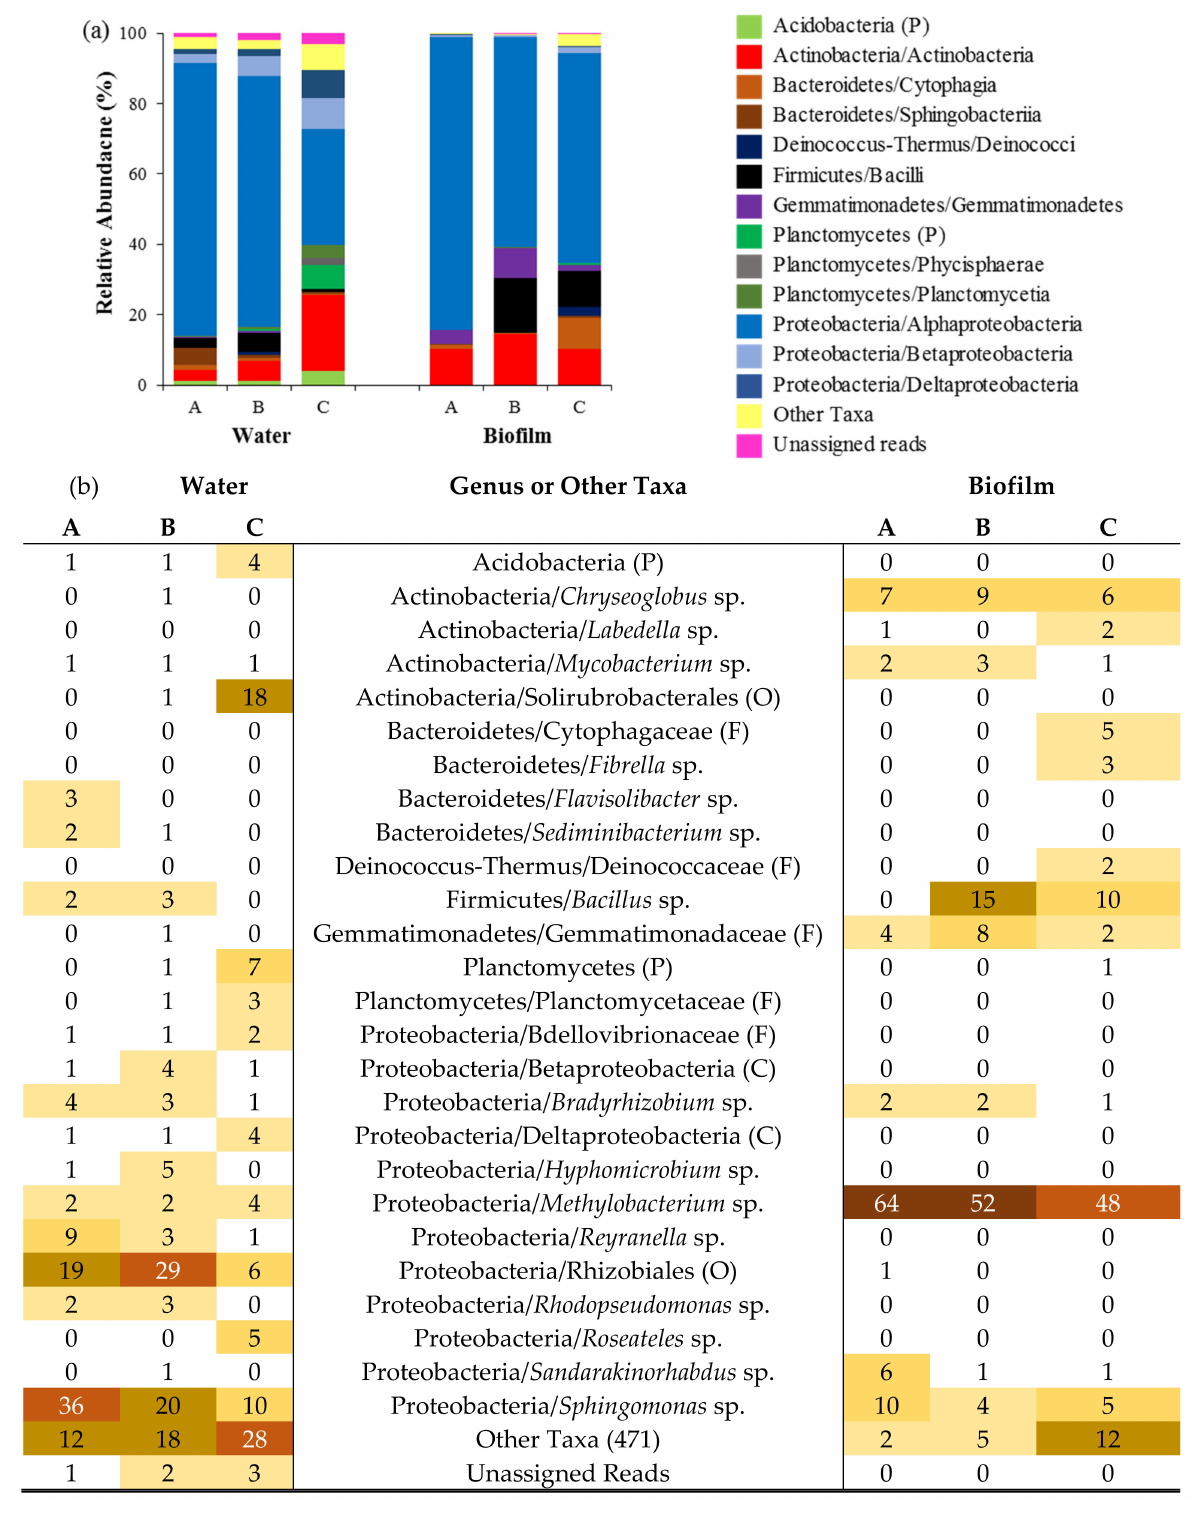
Figure 6. Variation in bacterial community composition within water and biofilm between fountain types (A, B and C). ( a ) Variation in relative abundance (%) of phyla and classes. ( b ) Heatmap showing the relative abundance (%) of bacteria at the genus level and at higher taxa levels within fountain types for biofilm and water. The letters in brackets correspond to family (F), order (O), class (C) and phylum (P). The numbers indicate the mean relative